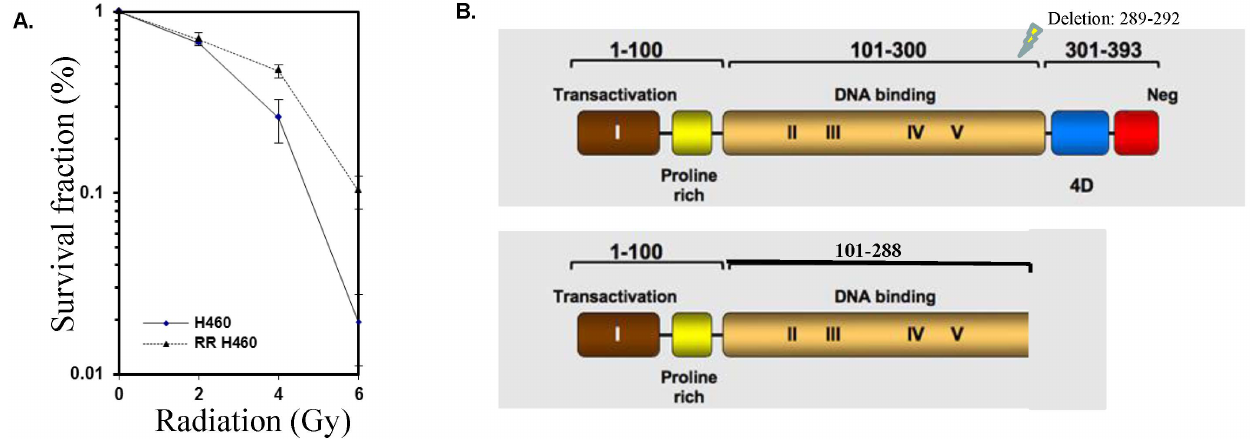
Figure 1. Identification of a novel radiation-induced p53 mutation that confers resistance to subsequent radiotherapy. H460 cells (p53-competent) were exposed to sequentially higher doses of radiation, then incubated at 37 u C for 8–10 days. One surviving (radiation-resistant) clone was selected and expanded to create a radiation-resistance H460 cell line (RR-H460). To confirm the effect of novel deletion on cell survival, a second radiation of 6 Gy was applied to cells from the parental and RR lines. A. Radiation resistance was confirmed by clonogenic assay after treatment with 0–6 Gy. A significant (p , 0.007) difference in survival between the radiation resistant colony and the parent cell line was noted at doses of 4 or 6 Gy. SF=0.2. B. Sequencing analysis revealed a novel deletion mutation at the end of the DNA binding domain of p53. Figure modified from the TP53 website (p53.free.fr).